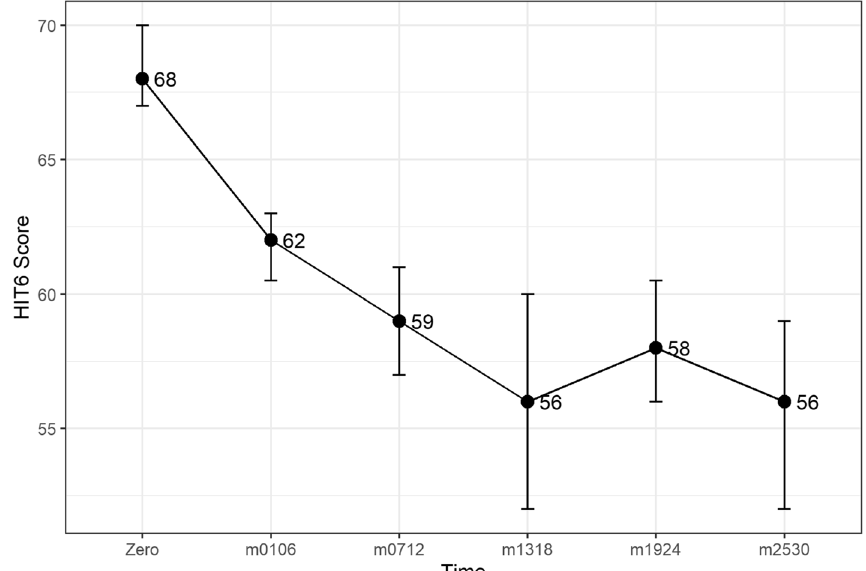
Fig. 1 Median HIT6 score (y-axis) at baseline and up to 30 months of follow-up (x-axis). Ninety-five percent confidence interval of median shown by vertical